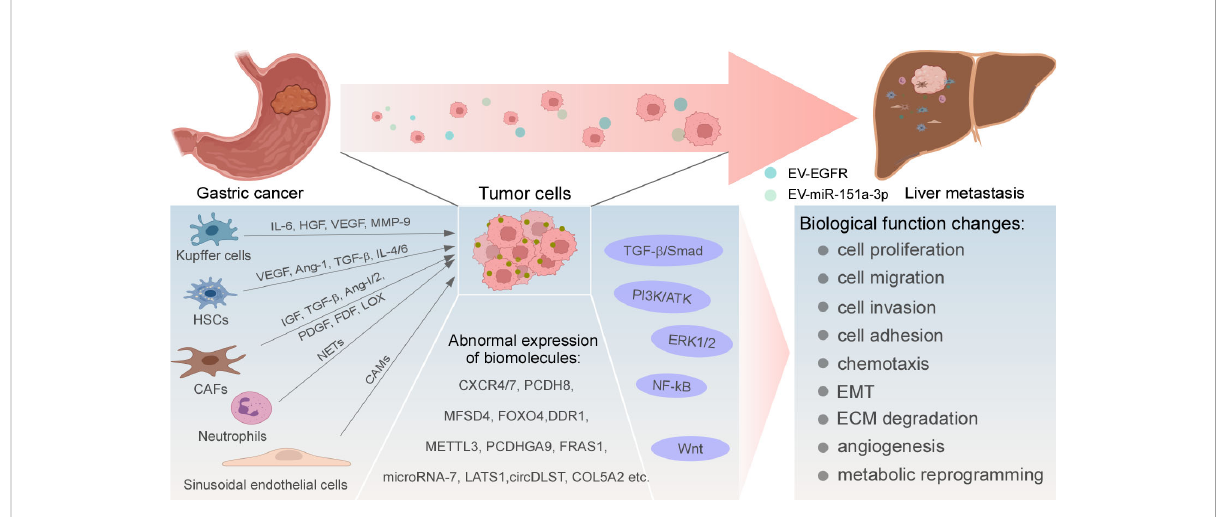
FIGURE 1 Regulatory mechanisms of GC liver metastasis. Abnormal expression and activation of biomolecules, signaling pathways, and cytokines produced by resident cells in liver TME drive uncommon alterations of GC cells in multiple cellular biological functions, ultimately leading to the development of liver